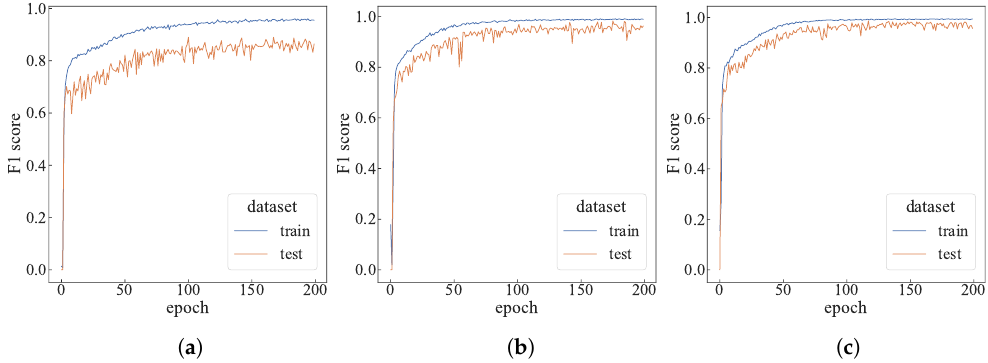
Figure 11. Performance comparison with different numbers of agents. ( a ) N = 5; ( b ) N = 15; ( c ) N = 20.